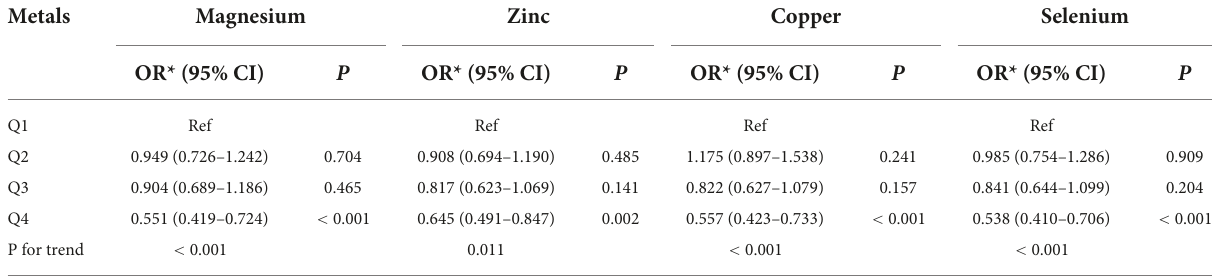
TABLE 6 Multivariate logistic regression analysis of the relationship between dietary metal intake and erectile dysfunction in national health and nutrition examination survey (NHANES) 2001–2004 after propensity score matching (PSM).